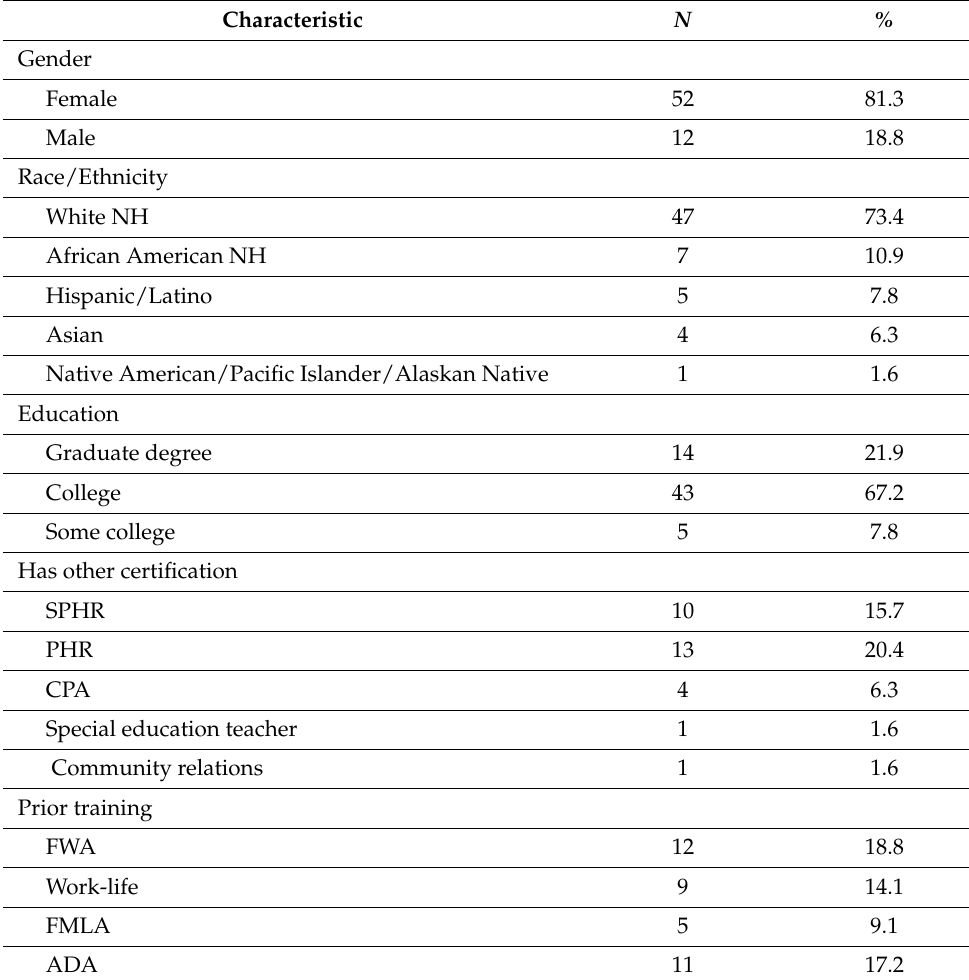
Table 1. Demographic characteristics of participants (N =